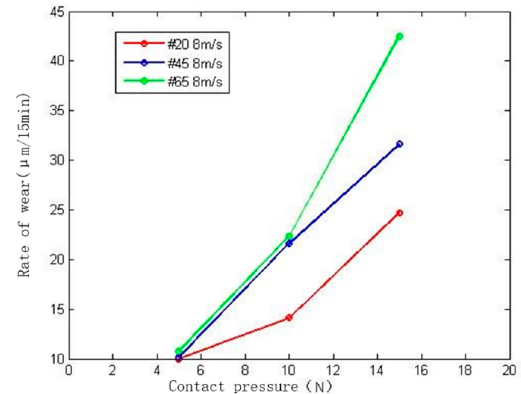
Figure 13. Influence of contact pressure on wear rate.